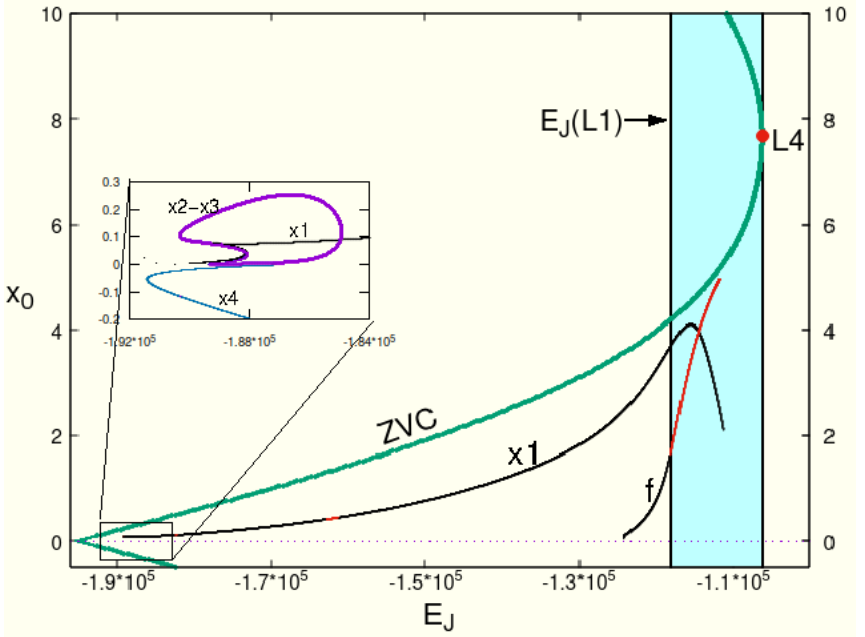
Figure 3. Characteristics of the main families of POs, x1 and f, projected in the ( E J , x 0 ) plane. Stable parts of these curves are plotted with black, while unstable with red, color. The zero-velocity curve is the thick green curve, having at its local maximum the L 4 point. The area between the E J ’s of L 1 and L 4 is shaded with cyan color. In the embedded frame, we give an enlargement of the characteristics of all main families close to the center of the system (see text). The x2-x3 loop is plotted with magenta, the x1 characteristic with balck and that of x4 with blue